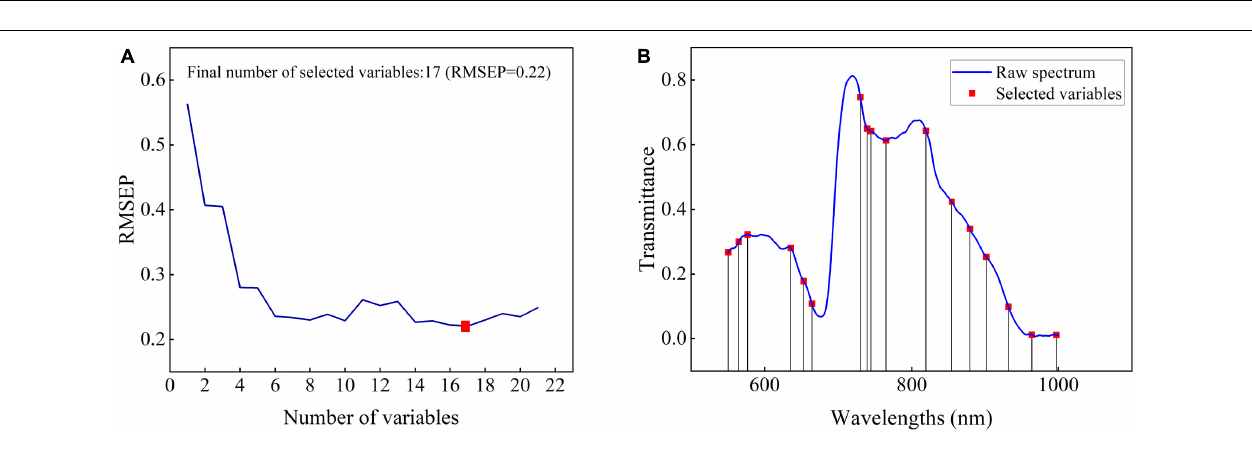
FIGURE 2 | The change of nVAR (A) , RMSECV (B) , and weights for variables (C) in each iteration of the BOSS algorithm.